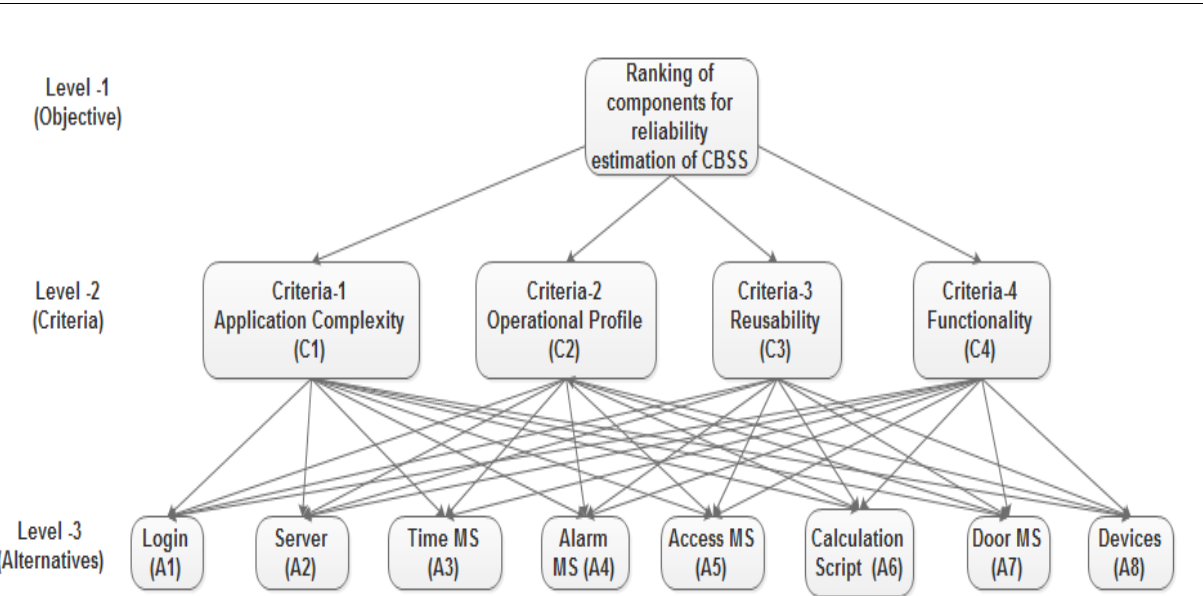
Fig. 1. SMS reliability estimation problem